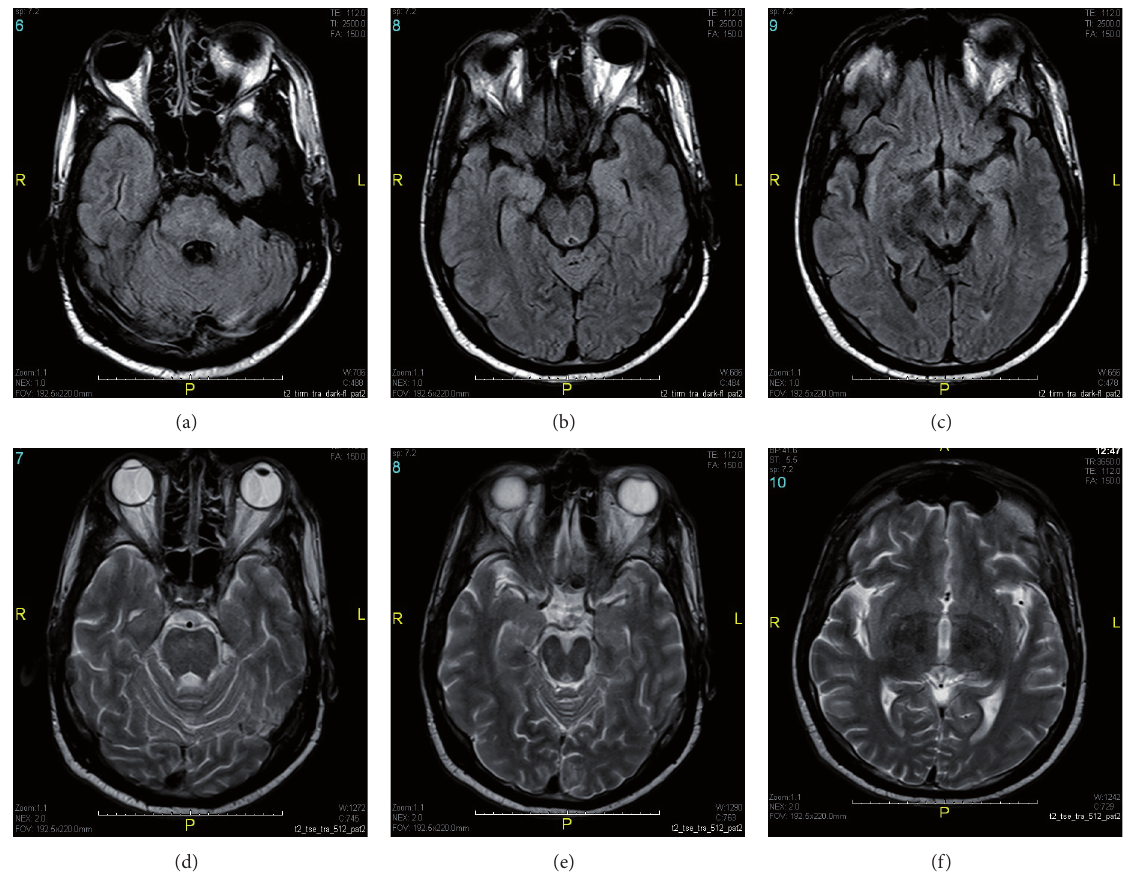
Figure 4: Follow-up non-contrast MRI after 12 days showing significant regression of the brain stem edema bright signal in FLAIR axial ((a)–(c)) and T2WI ((d)–(f))